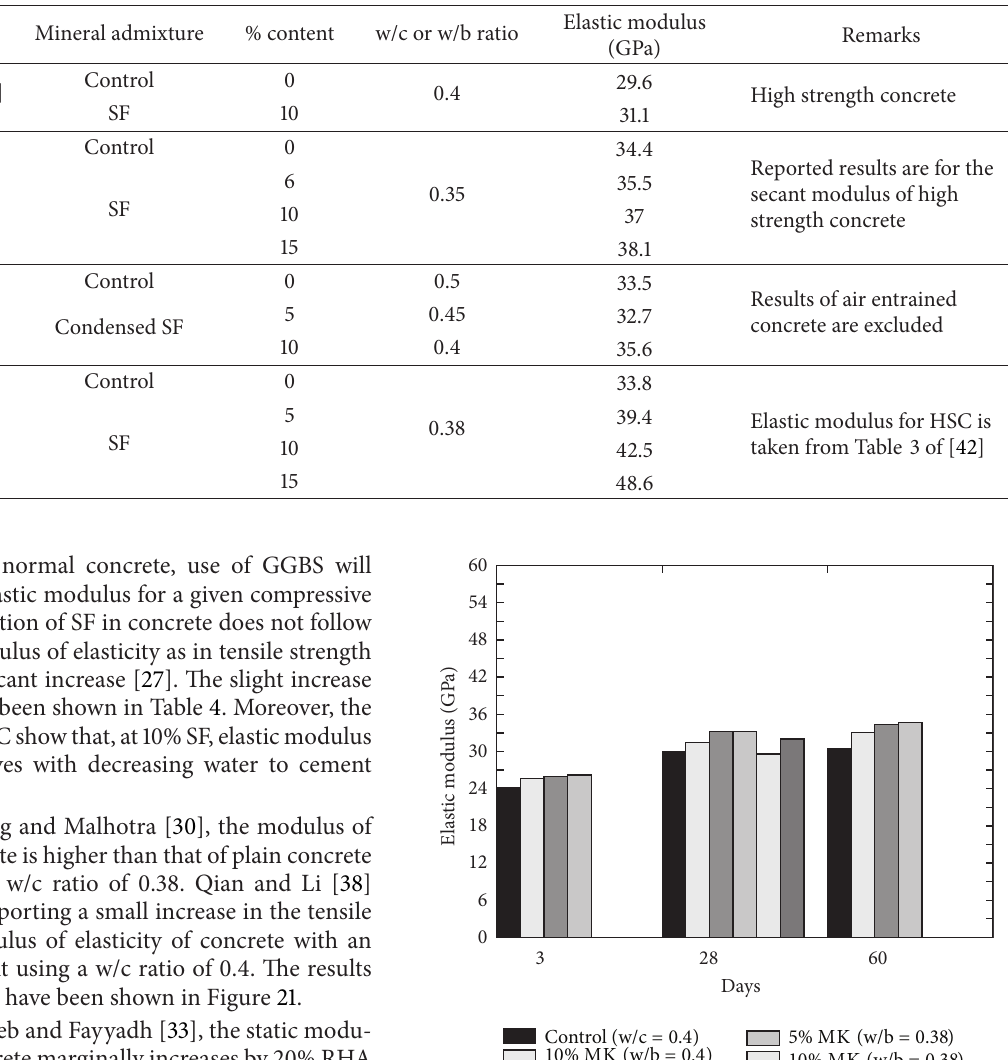
Table 4: Elastic modulus of SF concrete at 28 days.